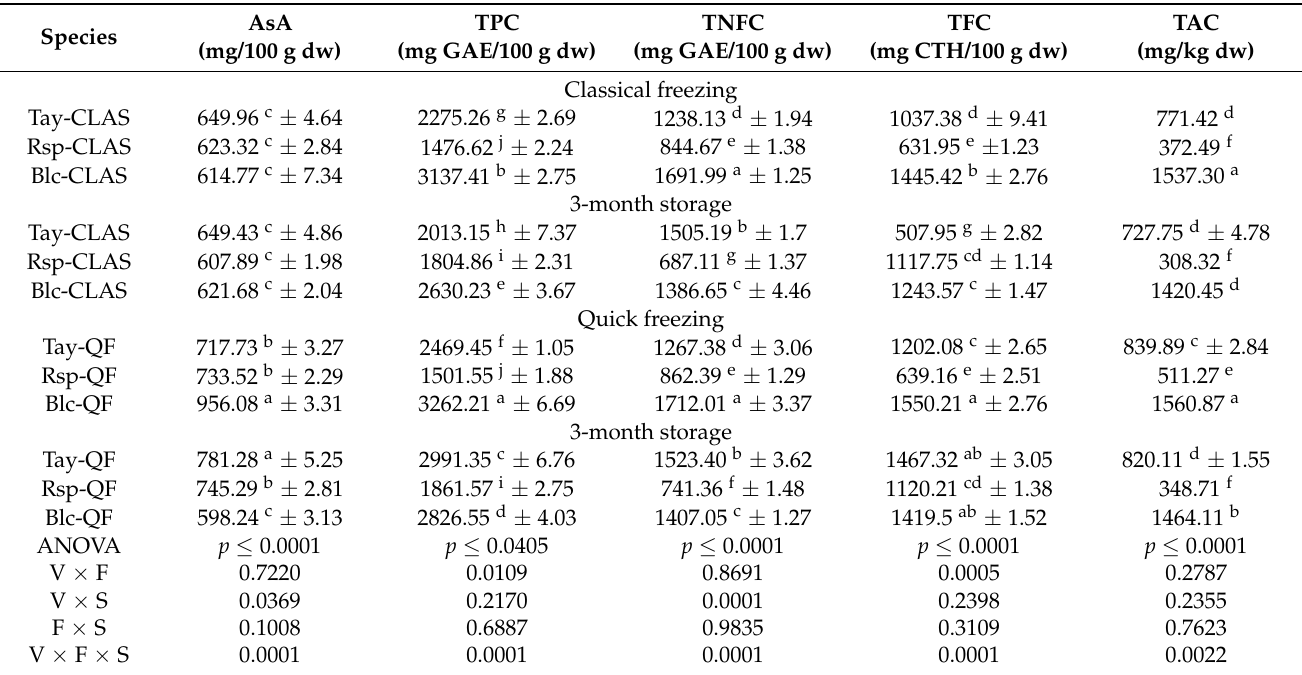
Table 7. Content of bioactive substances in frozen berry